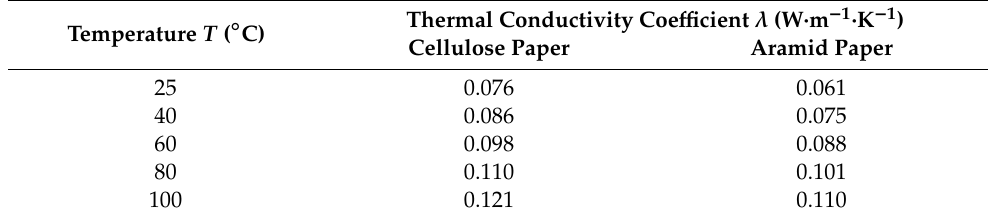
Table 2. Thermal conductivity coe ffi cient λ of cellulose and aramid unimpregnated papers at di ff erent temperatures T